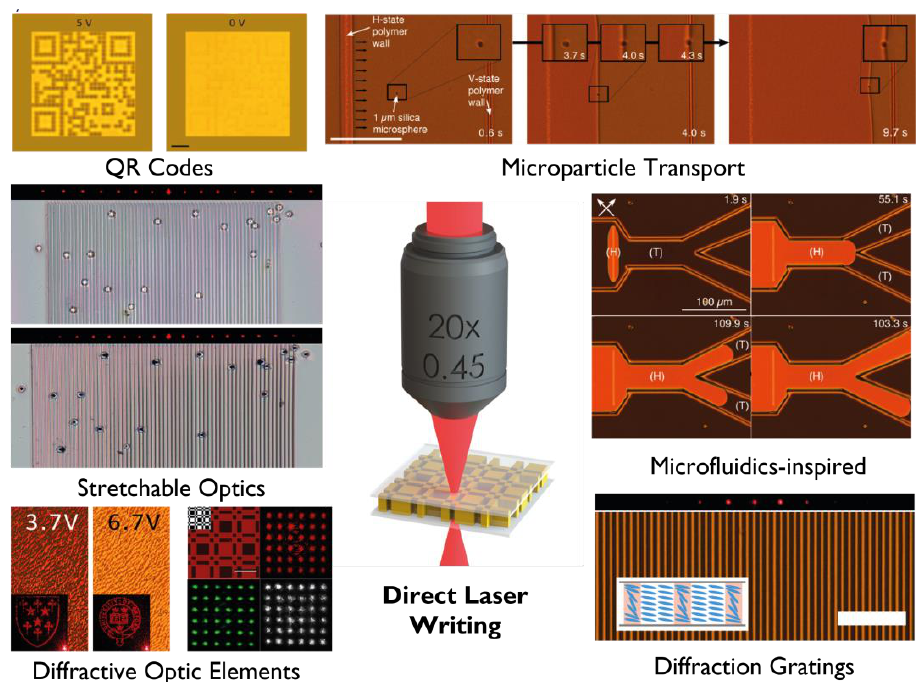
Figure 1. The range of functionality that our group has demonstrated using TPP-DLW in LC devices when an electric field is applied during fabrication [43,55 – 57]. This includes the development of switchable QR codes [55], microparticle transport and microfluidics inspired flow of defect walls [56], and diffractive optic elements in the form of one-dimensional diffraction gratings, Dammann gratings, and computer-generated holograms [43,57]. The focus of this paper is to demonstrate how this technique can be used to develop mechanically tuneable diffractive optic